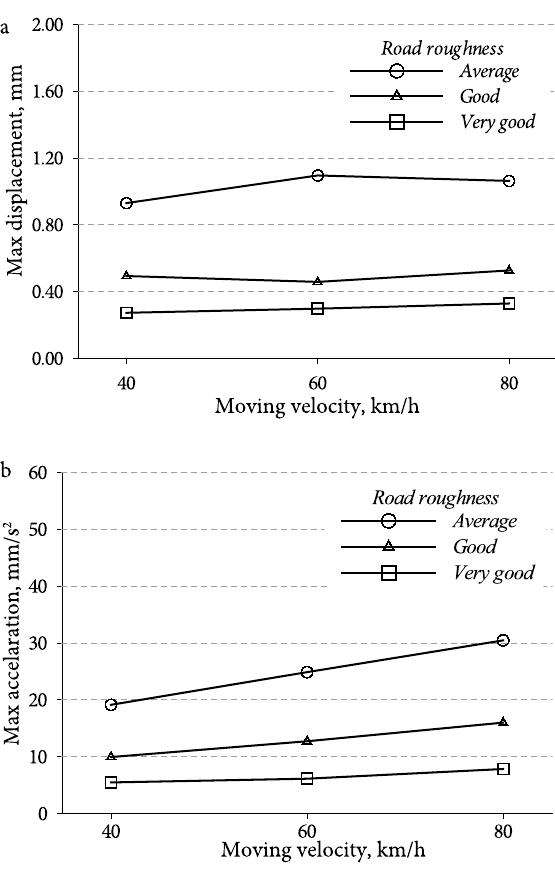
Fig. 14. Characteristics of vibration according to vehicle weight: a – displacement; b –